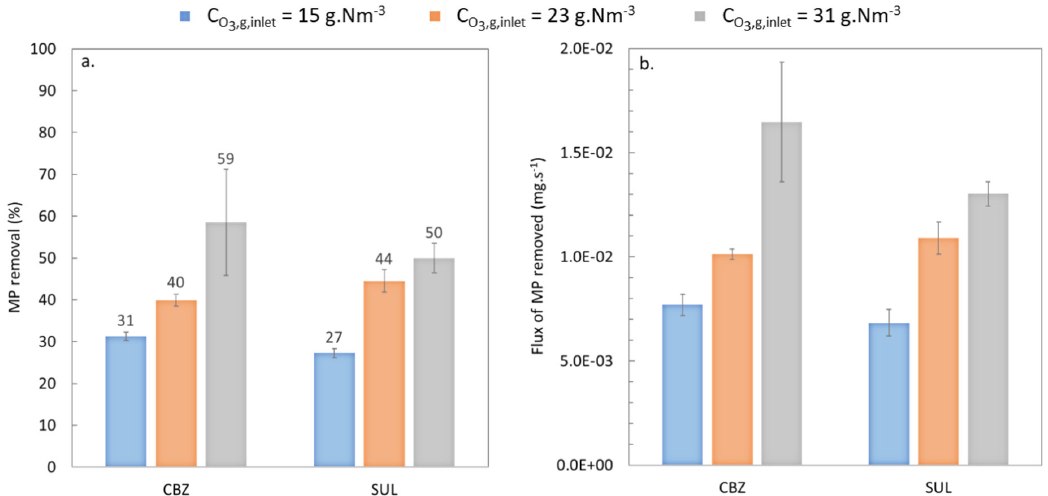
Figure 6. Abatement of CBZ and SUL at ozone concentrations in the gas ‐ phase inlet of 15, 23, and 31 g.Nm − 3 , a liquid flowrate of 46.2 L.h − 1 and a gas flowrate of 8 L.h − 1 at neutral